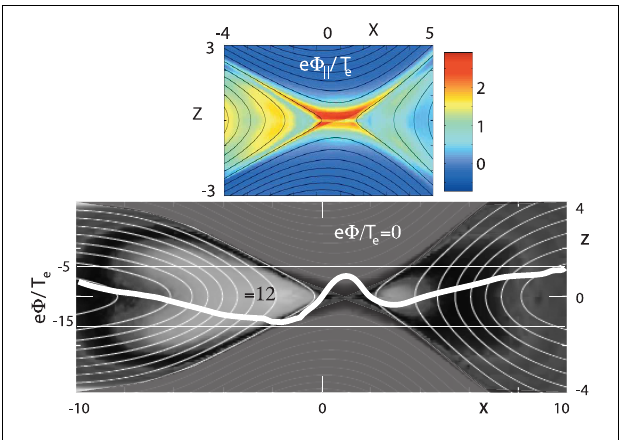
FIGURE 14 | Finite normal magnetic field component. Bottom: Gray scale image of the total electric potential in a real mass ratio m i / m e = 1600 two-dimensional simulation of forced reconnection [after 175, courtesy American Geophysical Union]. The potential is normalized to thermal energy. It varies between the values 0 and − 15. The fat white line is the potential along z = 0 showing a minimum of about − 7 in the X point and maximizing at around − 15 at the earthward plasmoid boundary. Top: Normalized parallel potential in the inner region around X point in color coding. The potential is asymmetric in z and in x maximizing at the separatrices and in the boundary of the earthward plasmoid. This potential is responsible for generation of field aligned currents and acceleration of electrons along the field. Asymmetry is caused by the finite B z